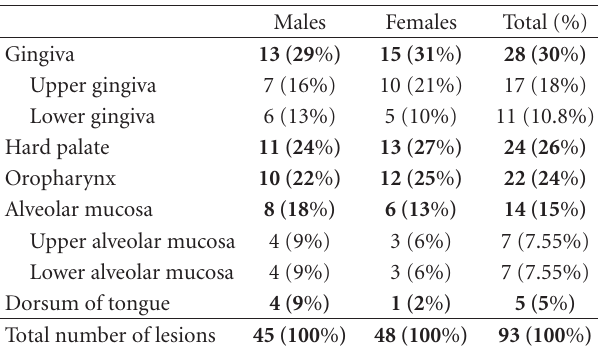
Table 2: Oral sites a ff ected by oral HIV-KS in relation to